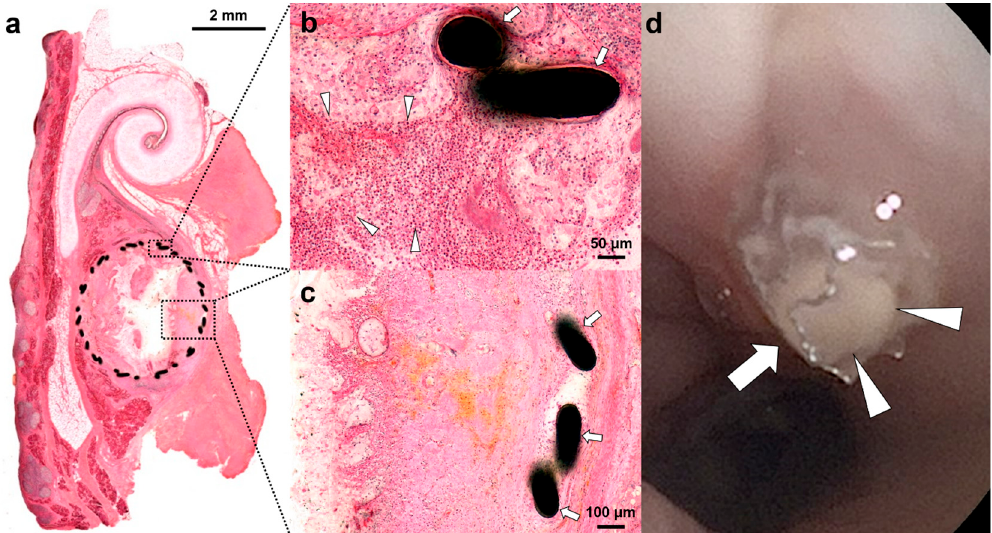
Figure 5. Representative histologic (hematoxylin and eosin staining at 1.25× ( a ), 20× ( b ), and 10× ( c )) and endoscopic images at 4 weeks after stent placement. ( a ) Microscopic image of a histologic section. ( b ) Severe inflammatory cell infiltration (arrowheads) adjacent to the stent strut (arrows). ( c ) Tissue hyperplasia with increased submucosal fibrosis through the stent strut (arrows). ( d ) Follow-up endoscopic image obtained 4 weeks after stent placement showing the stent (arrows) in place and the proximal end of the stent filled with secretion